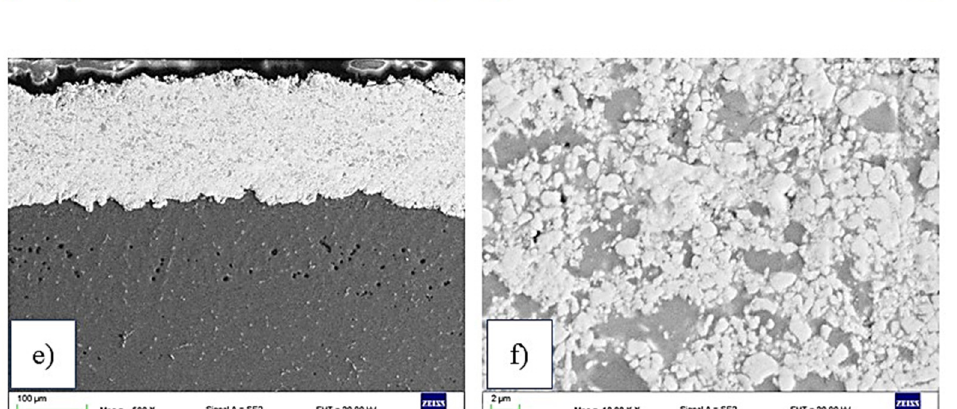
Figure 4. The chemical composition of the HVOF-sprayed coatings.